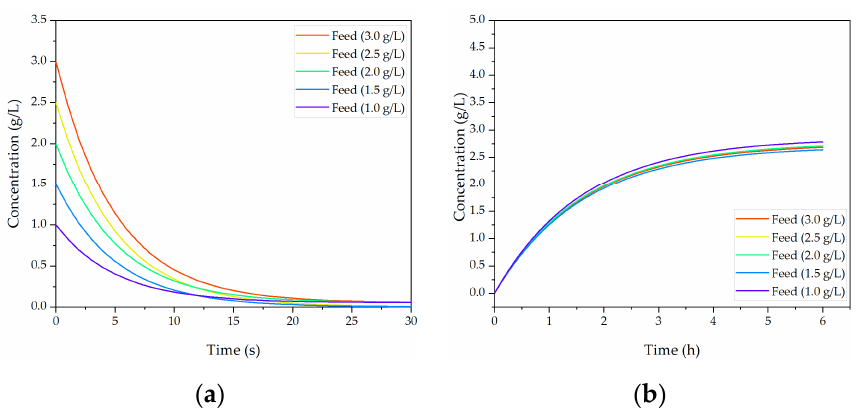
Figure 14. Simulation results for concentration fluctuations ( a ) and concentration compensation by system adjustment ( b , c ).